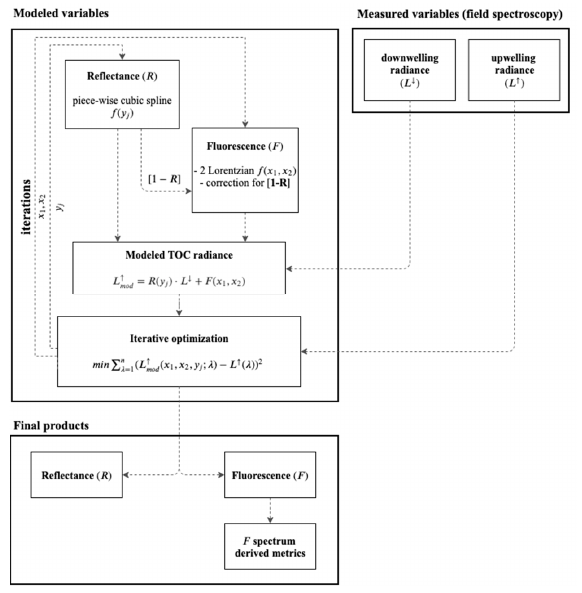
Figure 1. Flow chart of the fluorescence spectrum retrieval algorithm based on the Spectral Fitting technique for top-of-canopy observations (field spectroscopy).